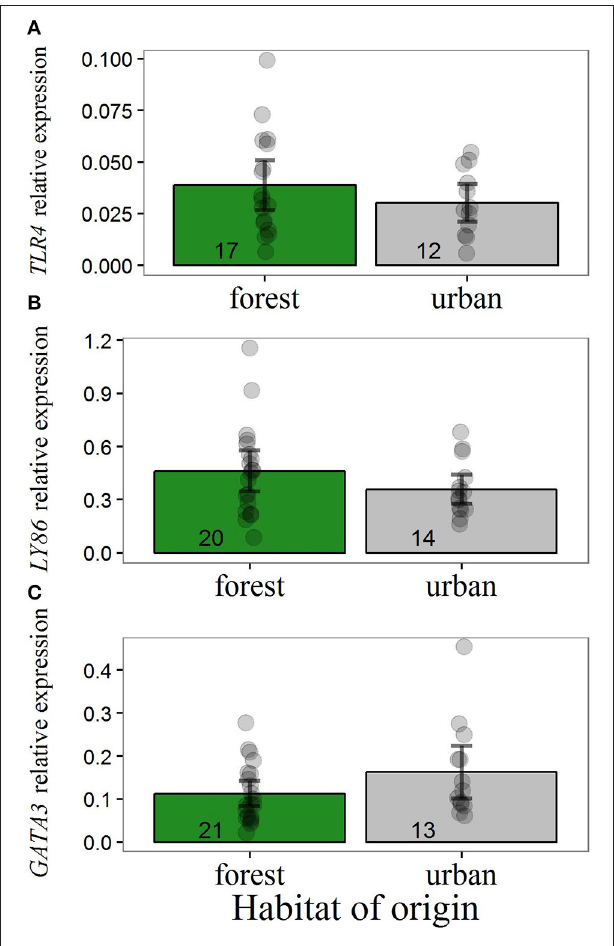
FIGURE 2 | Relative expression of (A) TLR4 , (B) LY86 , and (C) GATA3 for forest-reared nestlings hatched from cross-fostered eggs of the urban or forest site. Y-axis values refer to transcript levels relative to the expression of reference genes. Main bars illustrate raw data mean values and dark error bars illustrate ± 2 standard errors. Dots represent raw data points. Sample sizes are illustrated at the base of each bar. Removal of the urban outlier in GATA3 analysis (C) led to qualitative and quantitative changes in the results regarding this gene (Table S3). Differences in sample size between Figure 2 and Table 1 are due to two nestlings with missing information for body weight. The inclusion of these additional data points does not change the results regarding the effect of the rearing